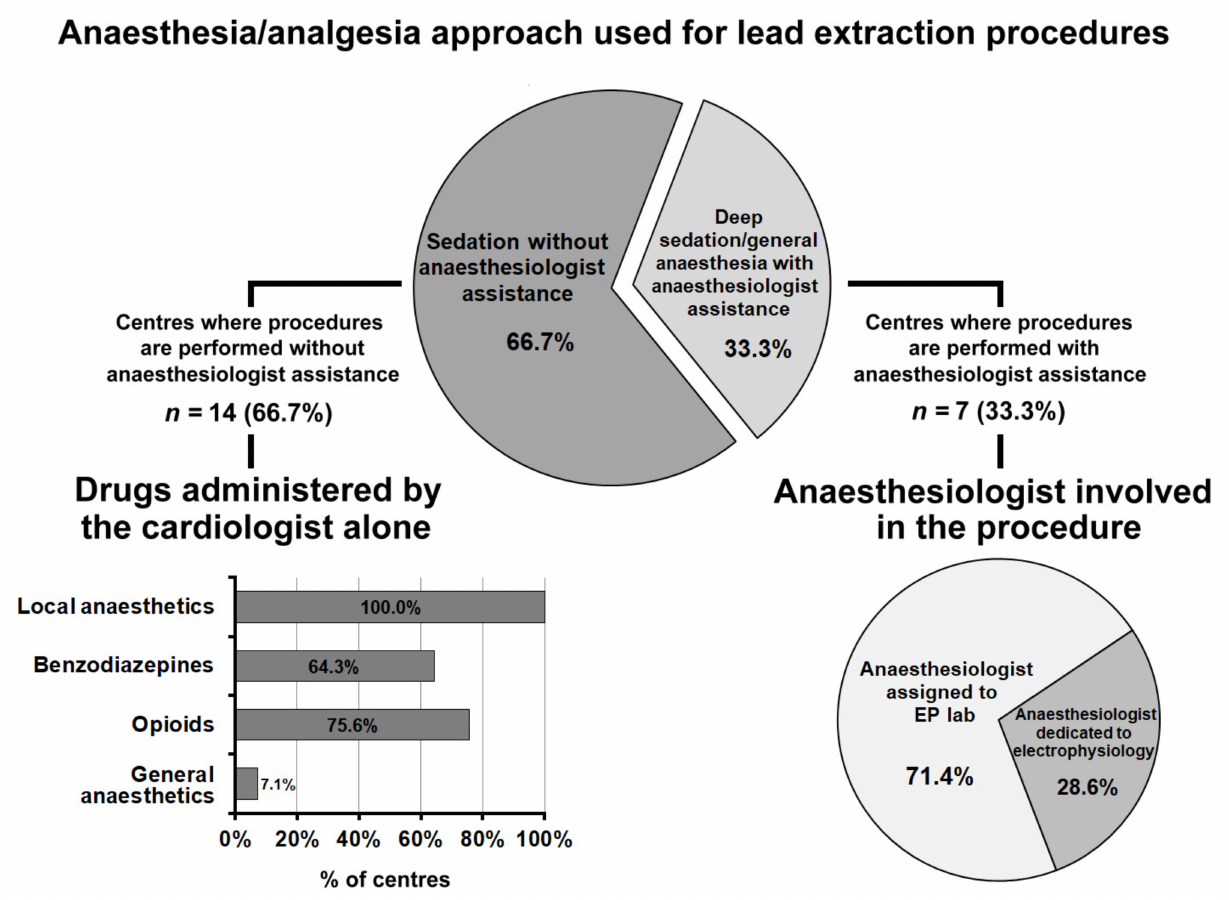
Figure 6. Anaesthesia/analgesia approach used for transvenous lead extraction procedures. Abbreviations used in the figure. EP lab: electrophysiology